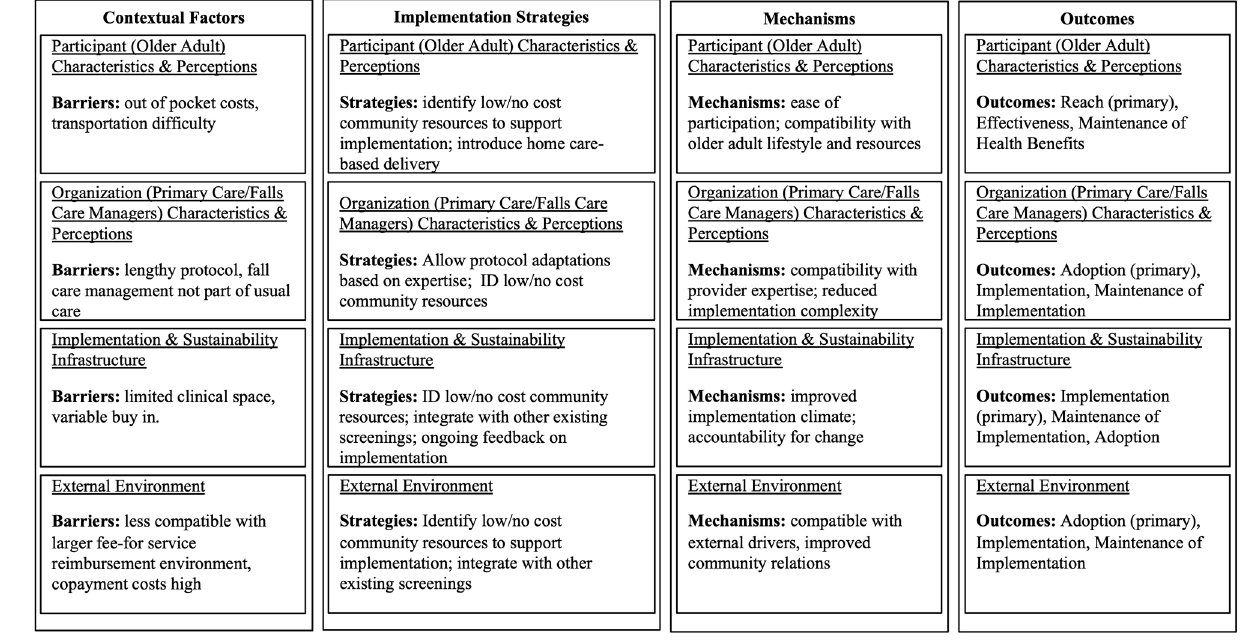
adapting to contextual changes undergirds DIS and illustrates how it is different than other types of health outcomes research (8, 11,